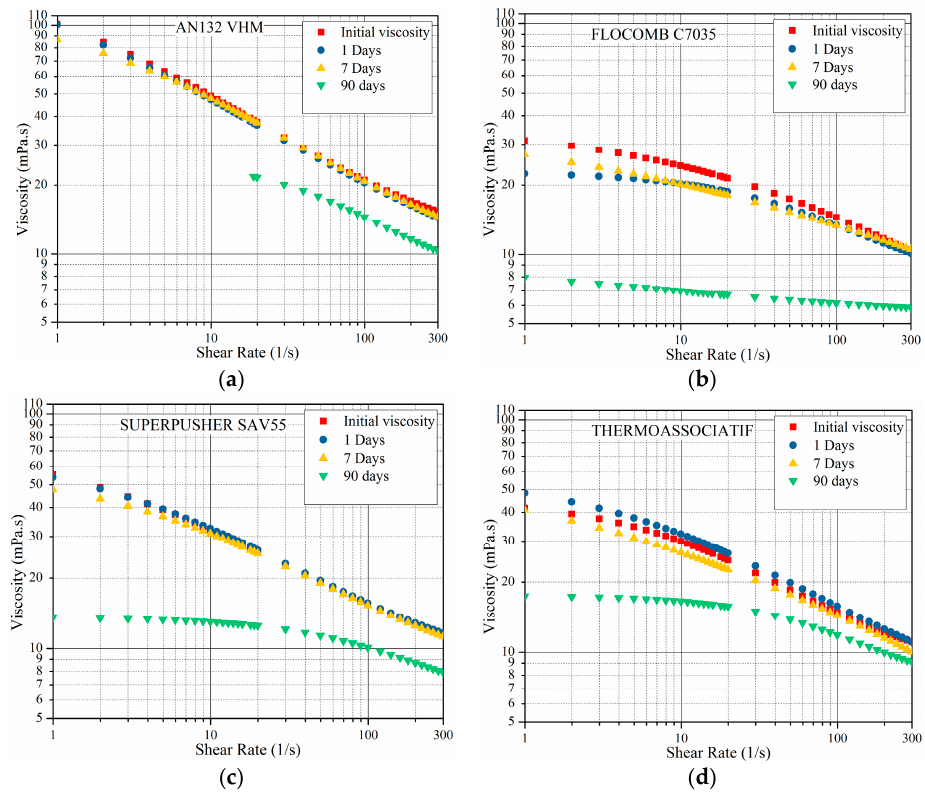
Figure 6. The viscosity as a function of shear rate measured at 25 °C for polymers in CaCl 2 -NaCl solution of same ionic strength as 5% NaCl and without IBA. Samples varied in aging time, ranging from 0 to 90 days at 80 °C.